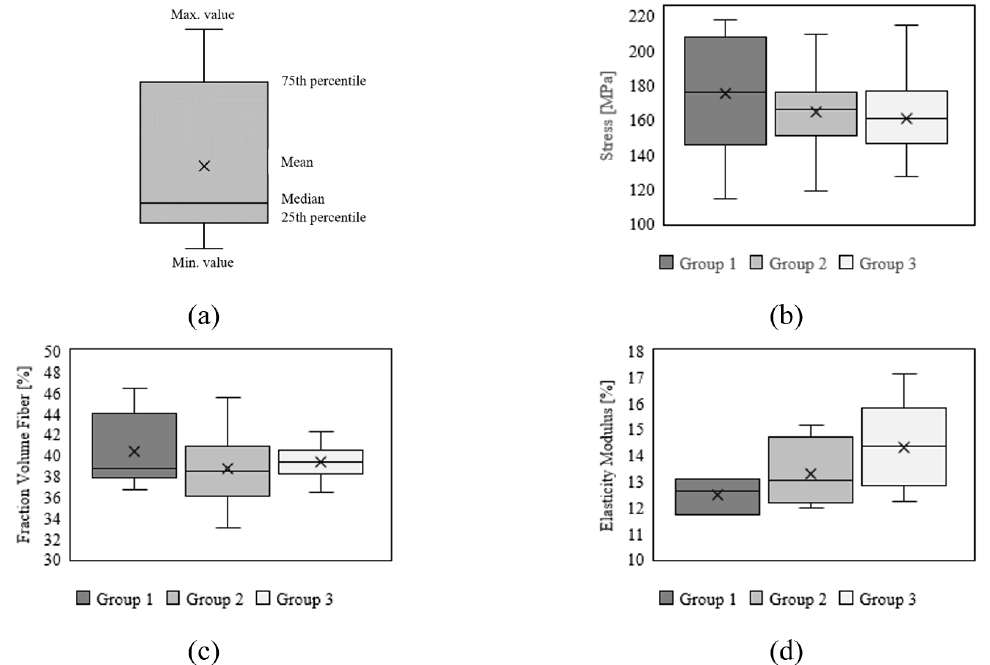
Figure 14. Box diagrams: (a) graphics legend; (b) ultimate tensile stress; (c) volume fraction of fibres; (d) longitudinal modulus of